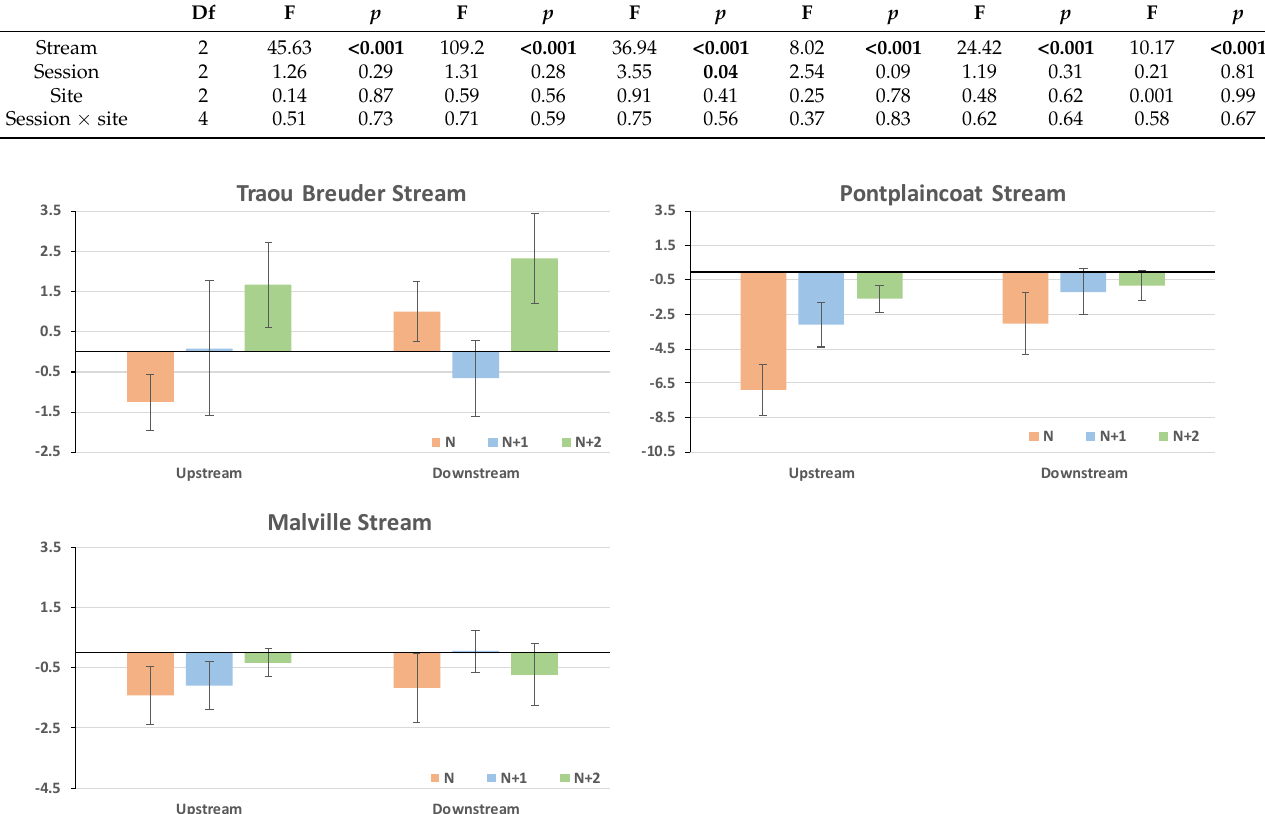
Table 4. Results of PERMONAVAs on the Bray – Curtis similarities (BCs) between macroinverte- brate communities before and after restoration (Before: before restoration; after1: first year of mon- itoring after restoration; after2: second year of monitoring after restoration; C = Control site; up = upstream section and down = downstream section). Traou Breuder Stream